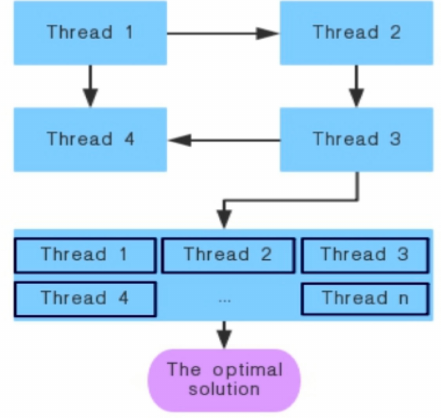
Figure 1. Parallel L é vy grey wolf optimization (LGWO) algorithm block